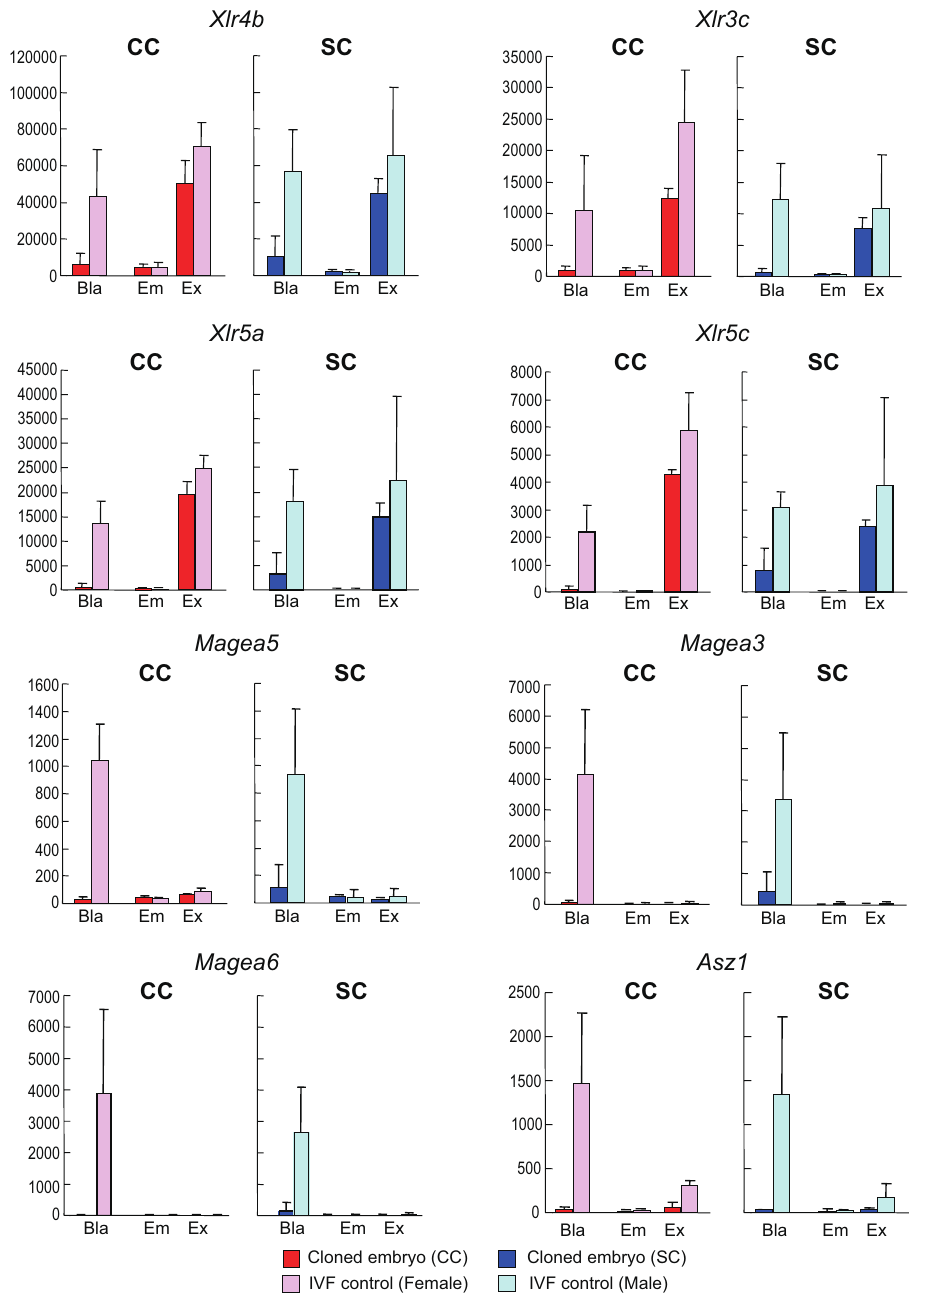
Figure 4. Expression of LOCKs-related genes in SCNT-derived embryos. Raw intensity values of LOCKs-related genes at E3.5 (blastocysts) and E6.5. The data set at E3.5 was from a previous study [12] (accession number: GSE23181). At E3.5, all the LOCKs genes examined were strongly repressed in SCNT-derived blastocysts compared with those in control IVF-derived blastocysts. At E6.5, after implantation, the genes were downregulated in the embryonic tissue and no significant differences were found between the SCNT- and IVF-derived embryos. By contrast, in the extraembryonic tissues, Xlr genes (e.g., Xlr4b , Xlr3c , Xlr5a and Xlr5c ) remained active after implantation and in the SCNT-derived samples the expression levels were restored to nearly normal. Bla, blastocysts; Em, embryonic samples; Ex, extraembryonic samples; CC, cumulus cell-derived clone; SC, Sertoli cell-derived clone.